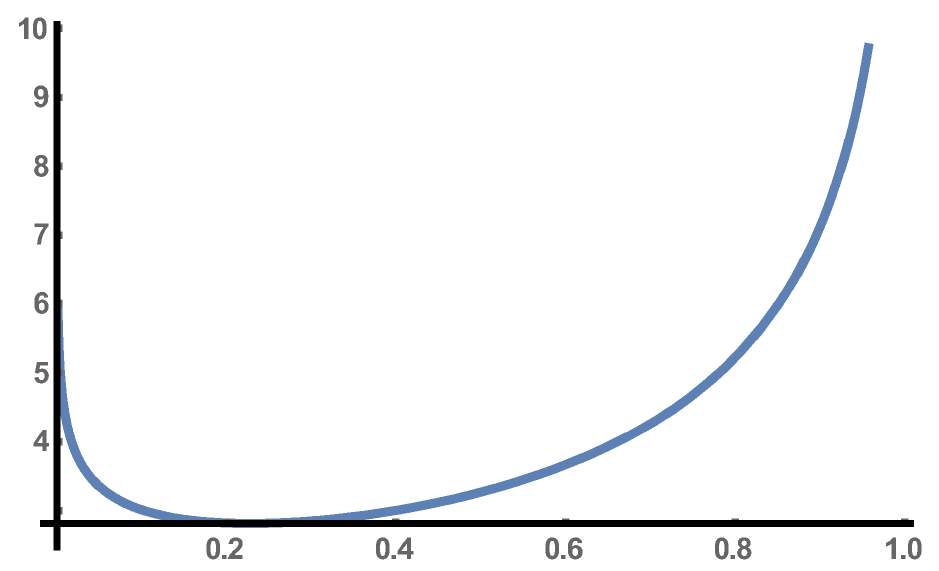
Figure 7. Graph of the real part of the solution (2) in the interval [ 0,1 ]